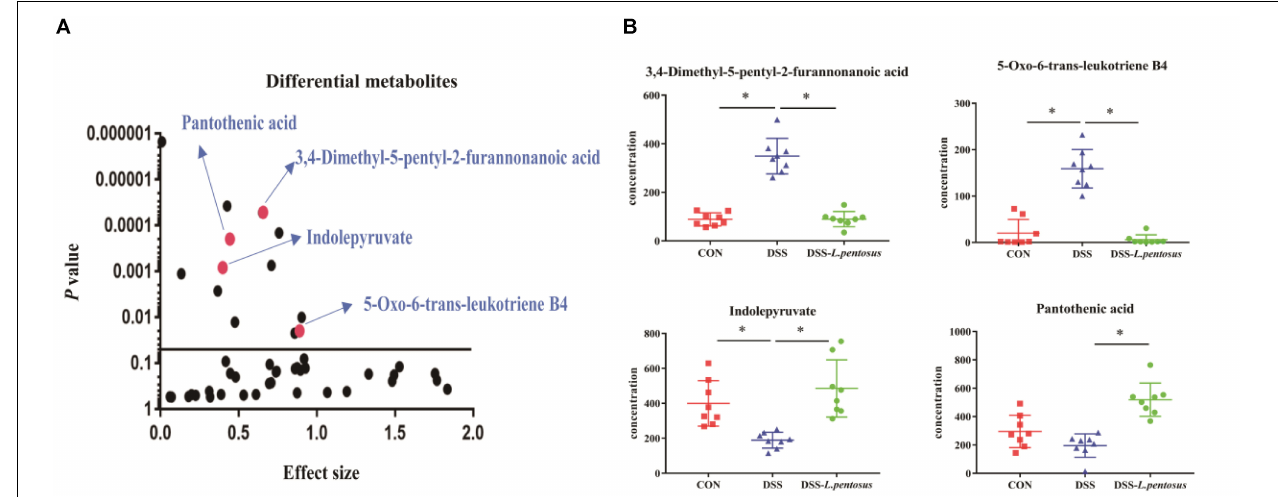
FIGURE 5 | Effects of different treatments on serum metabolite levels in mice. (A) Volcanic map of differential metabolite levels between the DSS and DSS- L. pentosus groups; (B) Serum levels of three group metabolic products.